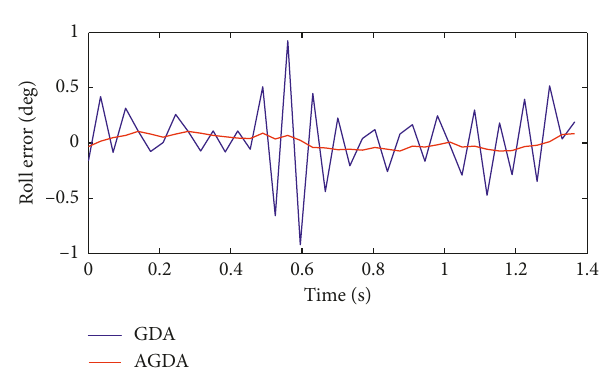
Figure 7: Roll angle error results.